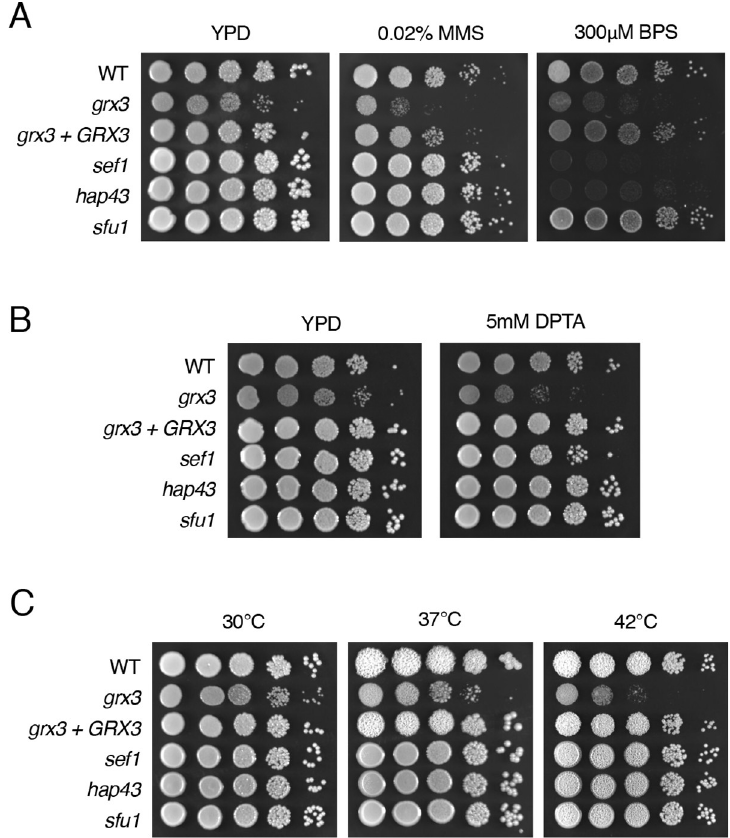
Fig 5. Grx3 contributes to cellular stress response. Sensitivity of grx3 to genotoxic stress ( A), nitrosative stress ( B ), and elevated temperature ( C ). WT (HLY4494), grx3 (HLY4492), grx3 + GRX3 (HLY4566), sef1 , hap43 , and sfu1 were serially diluted and spotted onto YPD plates containing indicated compounds and grown at 30˚C or indicated temperature for 2 days.